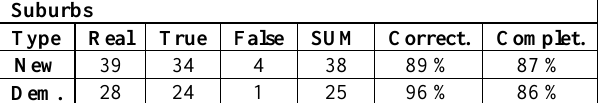
Table 4. Change detection results for suburbs